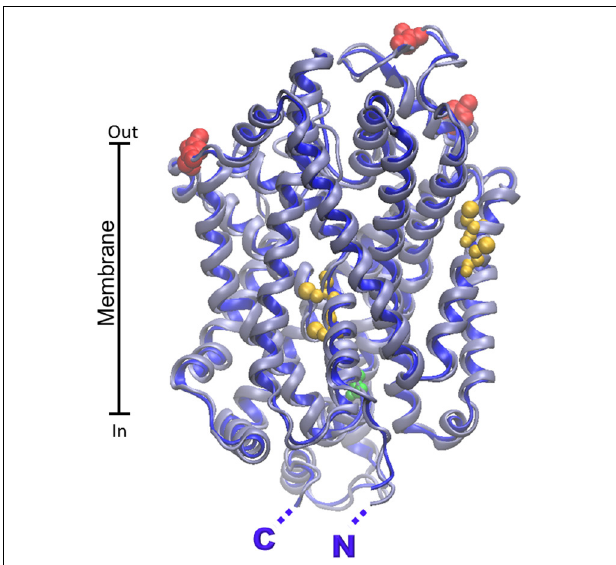
FIGURE 5 | Homology models of B0AT1 human and rat transporters. The homology structural models of rat (gray) and human (blue) B0AT1 were constructed as described in Figure 4 using as template the structure of dopamine transporter from D. melanogaster (PDB 4M48). RMSD for model comparison was calculated by Spdbv 4.1.0. Superposition of the rat and human structural models was performed by VMD 1.9.1. Putative glycosylation sites are highlighted in red; cysteine residues of the metal binding motifs are highlighted in yellow; PKC phosphorylation site is highlighted in green. N- and C- terminals of rat and human proteins are nearly coincident and highlighted by single N and